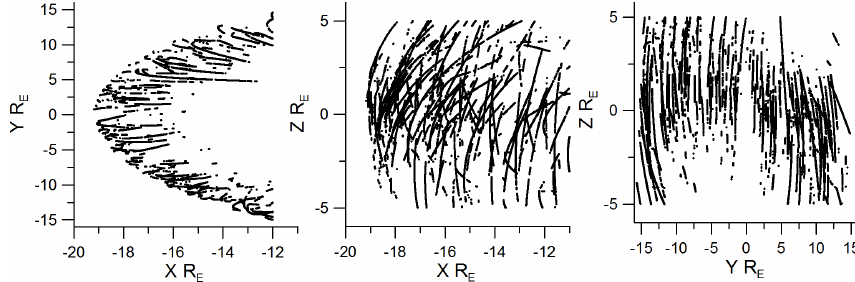
Fig. 1. Distribution of points of observation in the